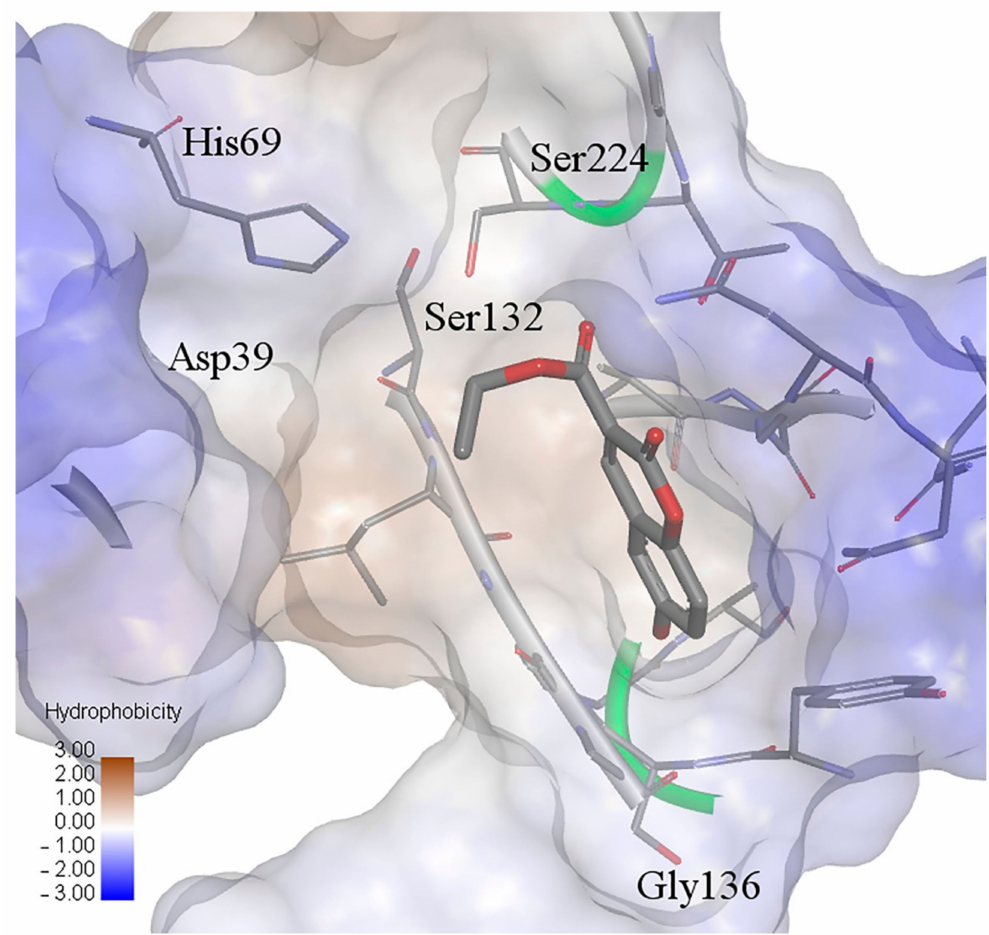
Figure 6. Hydrophobic surface representation of proteinase K active site with docked compound 6